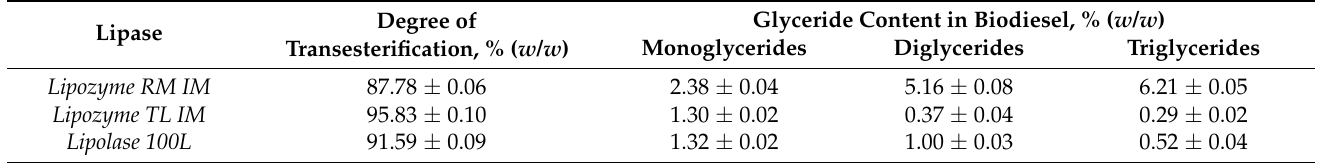
Table 2. The most efficient lipases using the in situ process.